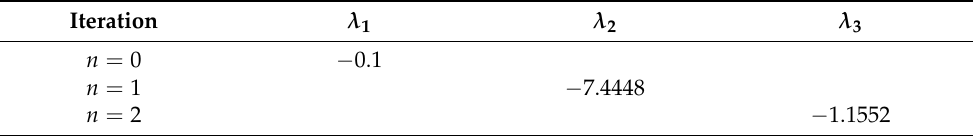
Figure 2. Output MATLAB simulation of the financial chaotic system (1) with Y (0) = (0.4, 0.2, 0.5) and ( a, b, c ) = (7.6, 0.1, 0.2): ( a ) x-y plane, and ( b ) Poincaré section of the financial chaotic system (1).